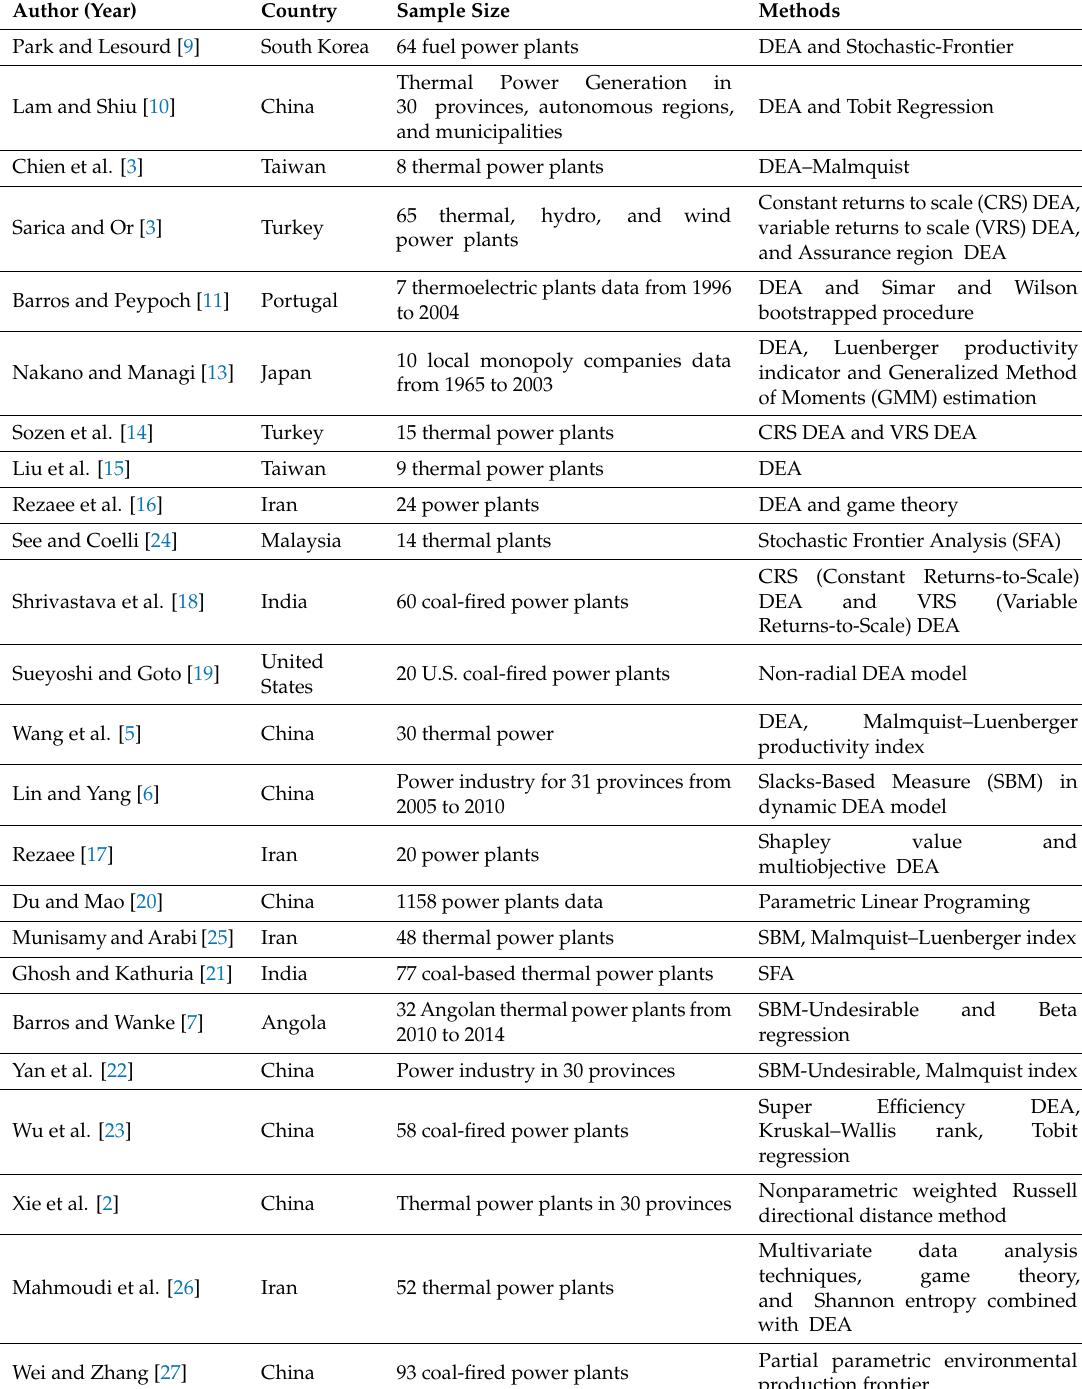
Table 1. Literature review